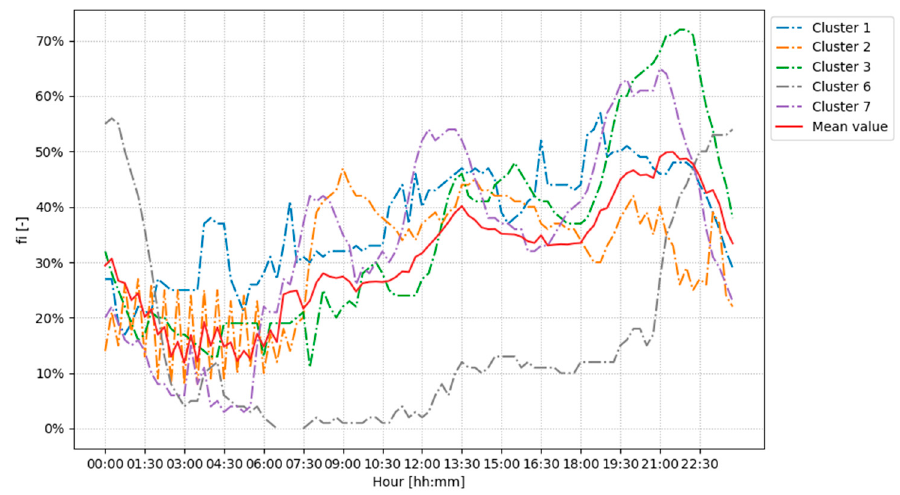
Figure 10. Daily usage probability: TVs.